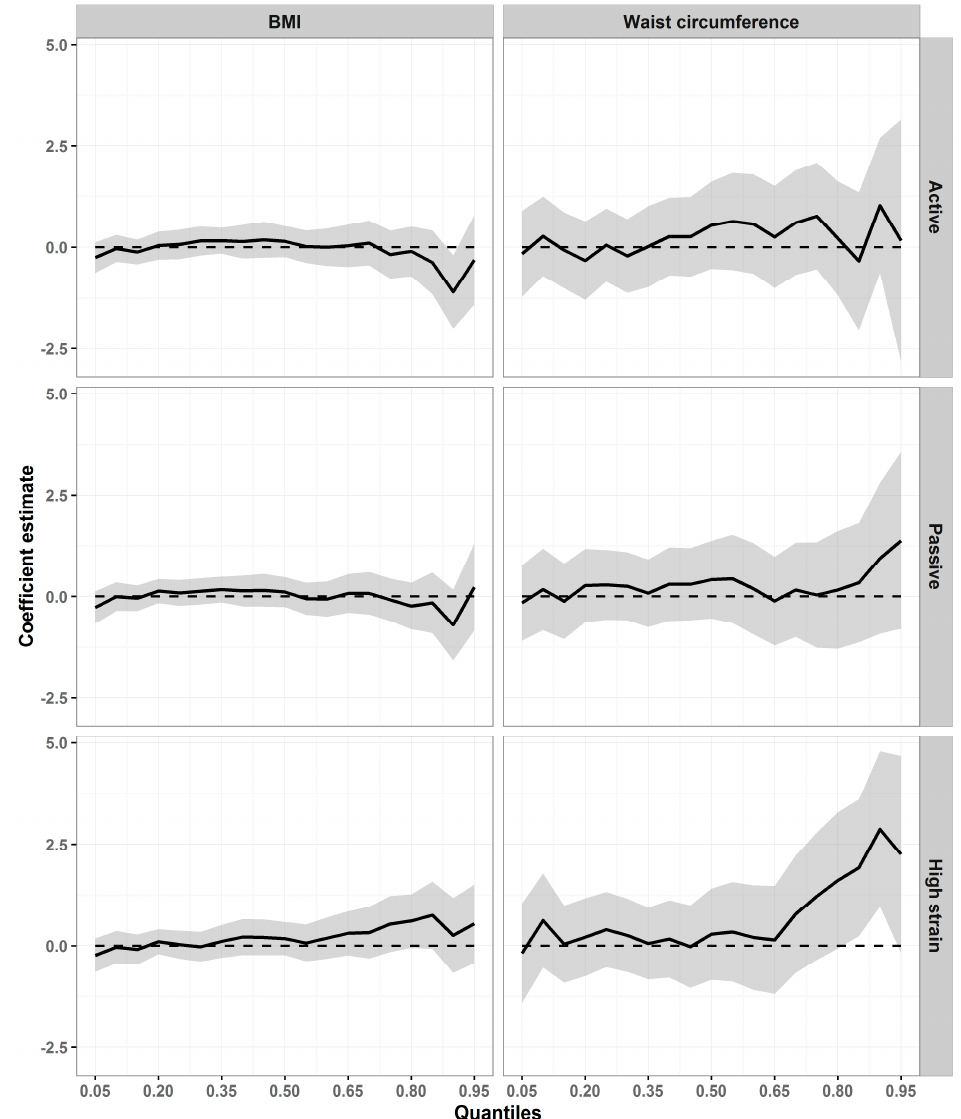
Figure 1. Association between job strain and adiposity (BMI and WC) in adjusted quantile regression models among women. ELSA-Brasil, 2008–2010 ( n = 6252). On the horizontal axes are the BMI and WC distribution percentiles; the vertical axes show the values of the coefficients estimated. The dashed parallel line represents the null value (zero), and a solid line stands for quantile estimates. The grey area surrounding the solid line represents the 95% CI for the quantile estimates. The coefficients are adjusted by age, schooling, per capita family income, hours worked weekly, and study center for BMI; and by age, schooling, per capita family income, and study center for WC.